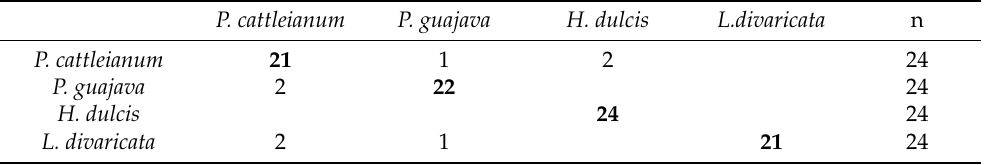
Table 8. Confusion matrix obtained from the LDA-LOOCV species classification model showing invasive and native species. Numbers in the diagonal of the matrix are the number of samples predicted correctly. Were: P. cattleianum- Psidium cattleianum ; P.guajava- Psidium guajava; H. dulcis - Hovenia dulcis ; L. divaricata- Luehea divaricata .